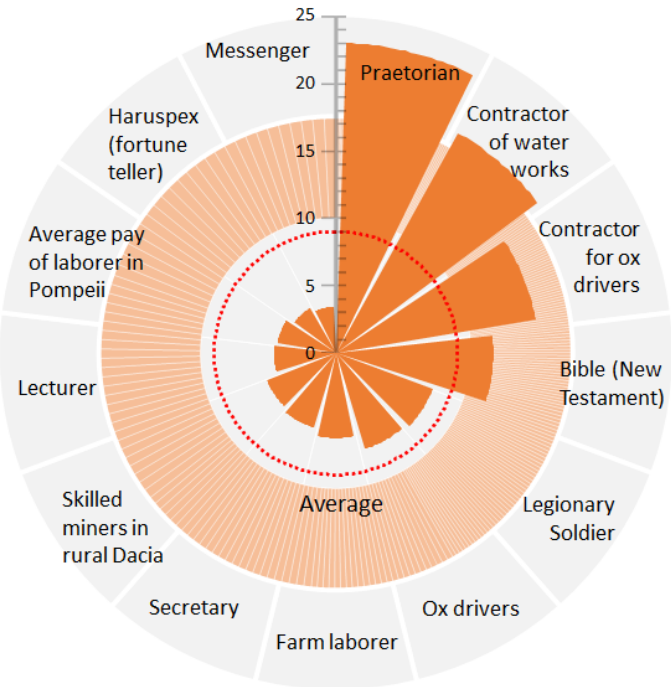
Figure 27. Visualization of Table 1. Daily wages in wheat in the Roman Empire in the 1st c. AD.